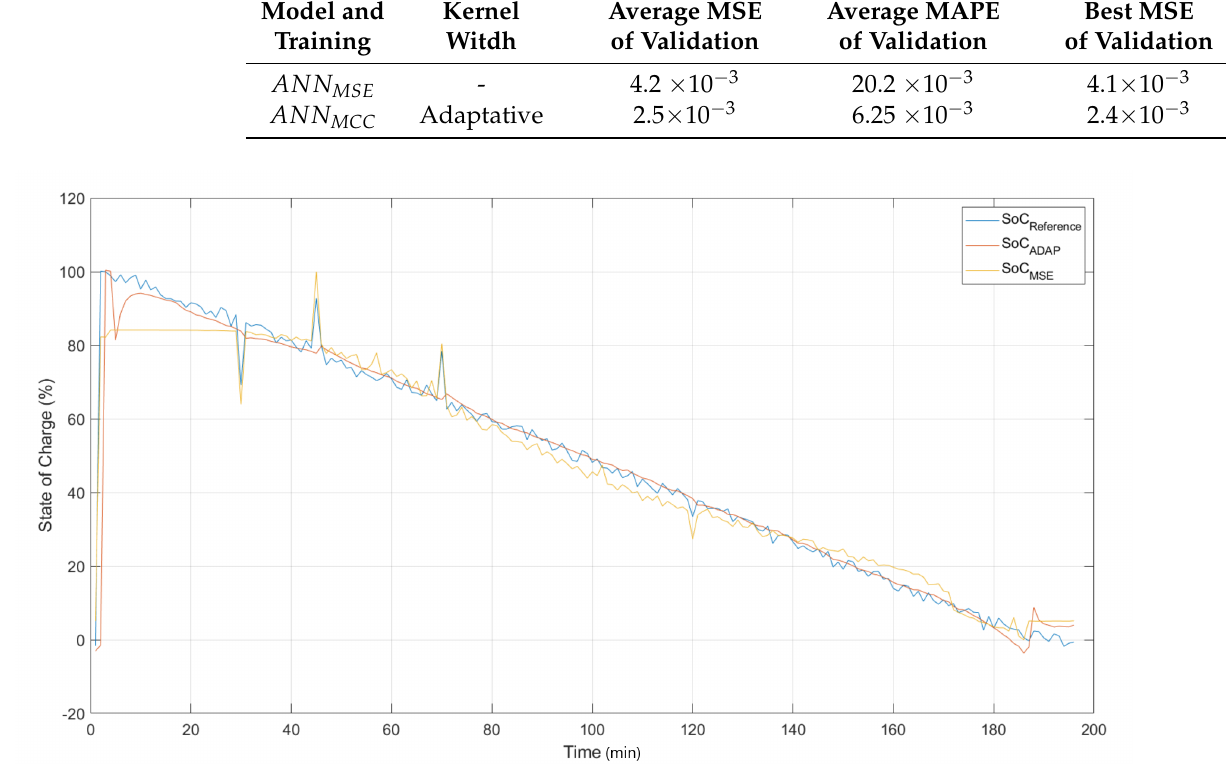
Figure 11. Validation of ANN models. State of Charge—training result with the presence of noise and outliers—Constant Current.